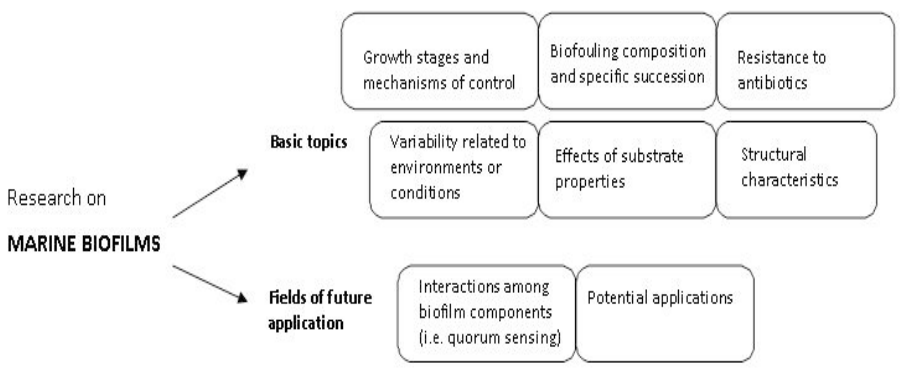
Figure 2. Basic and emerging topics of research on marine biofilms.